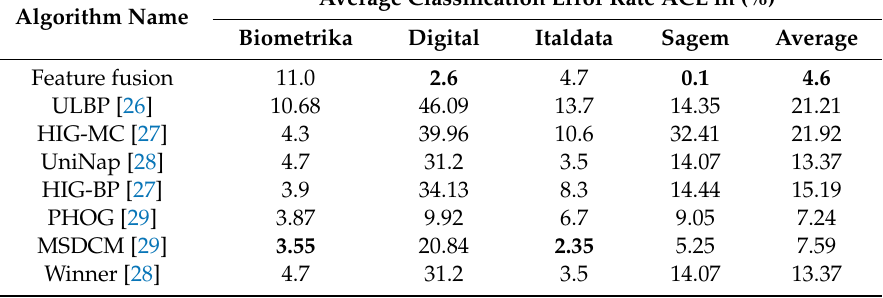
Table 9. The comparisons of the average classification error (ACE) of di ff erent algorithms in the LivDet 2011